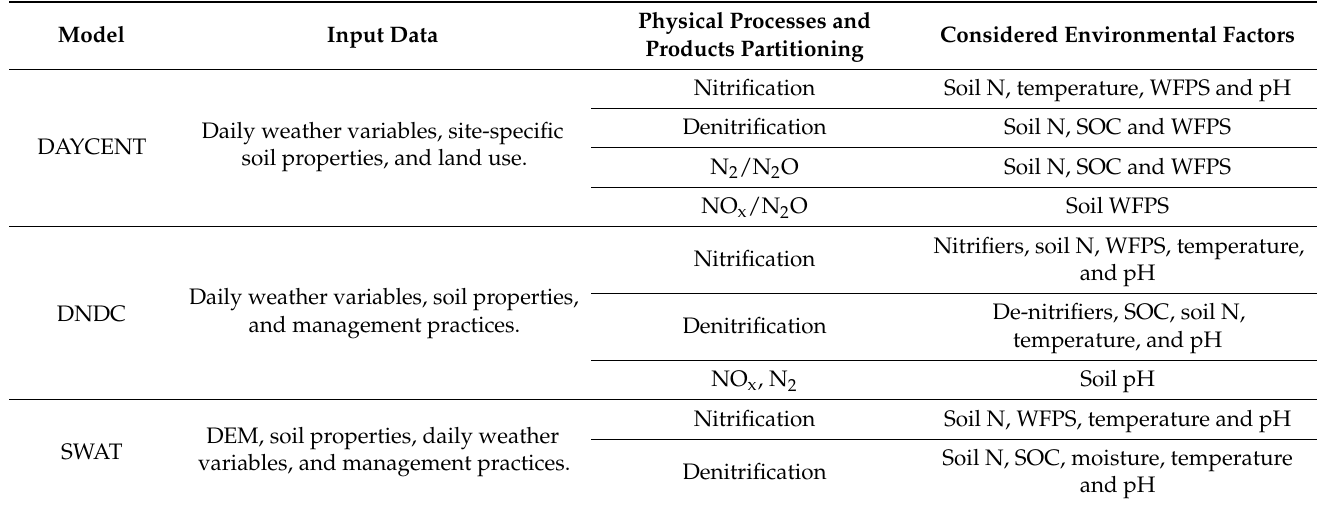
Table 5. Summary of three process-based models in simulating N 2 O